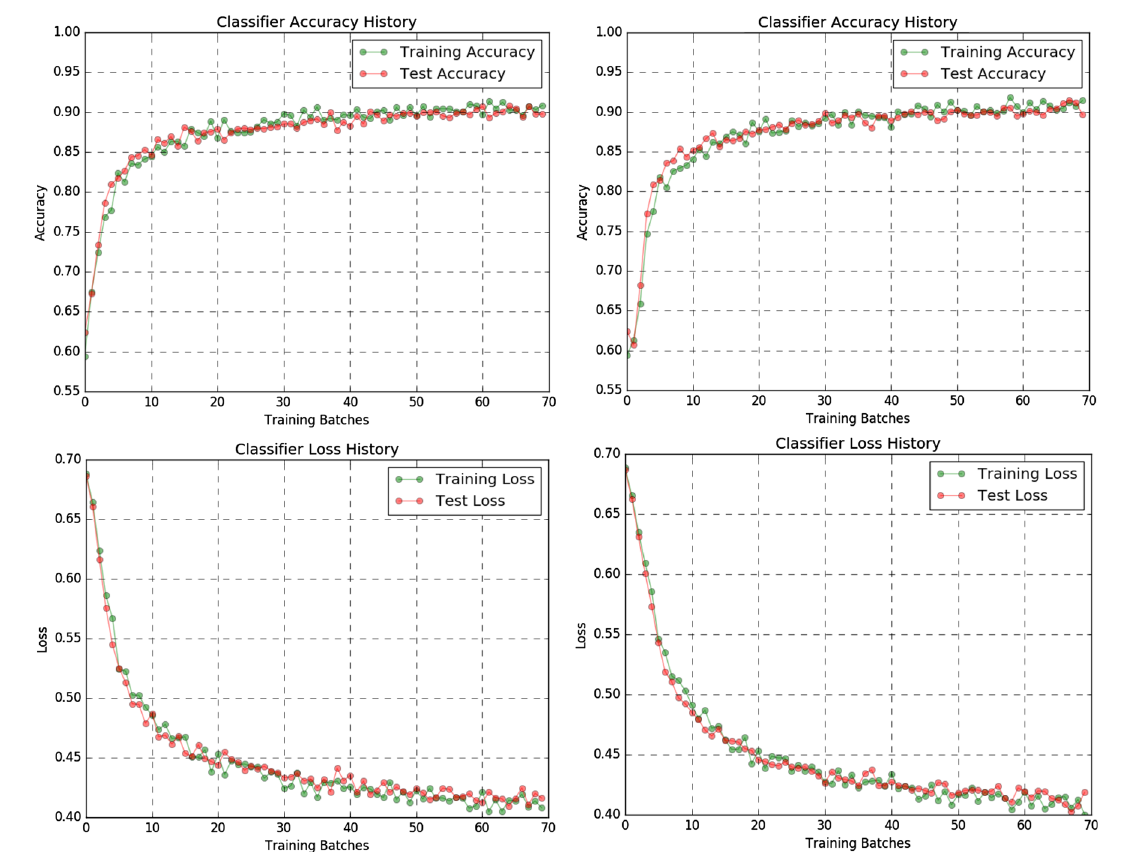
Fig. 20 Training history for different choices of the input 3D array zise: Accuracy (top) and loss (bottom) as a function of the training batch for photon/neutral pion classification, using a 25 × 25 × 25 (left) and 51 × 51 × 25 (right) ECAL window size